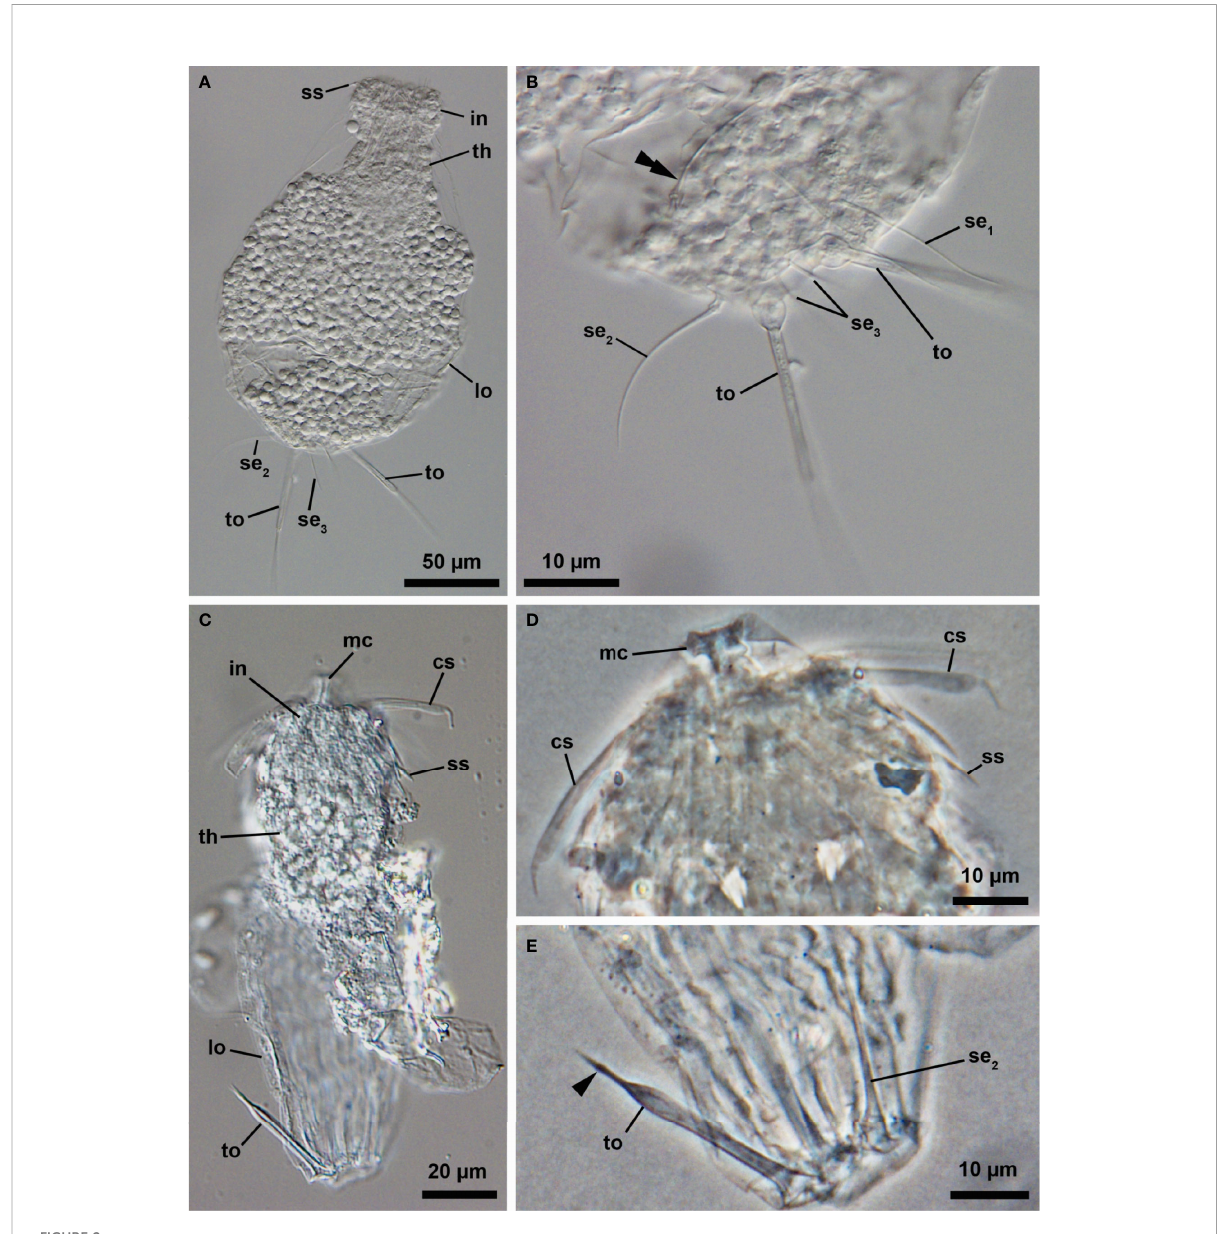
FIGURE 2 (A, B) Light micrographs of the molting Higgins larva of an undescribed species, Pliciloricus sp. 1 (NHMD-621045) (A) Overview. Ventrolateral view, anterior faces up. (B) Close-up of the posterior region of the body. (C – E) Light micrographs of the Higgins larva of an undescribed genus, (NHMD-621044) (C) Overview. Ventrolateral view, anterior faces up. (D) Close-up of the head. (E) Close-up of the posterior region of the body. Arrowhead points to a small bulge near the distal end of the toe. cs, clavoscalids; in, introvert; lo, lorica; mc, mouth cone; se 1 , posterodorsal seta;